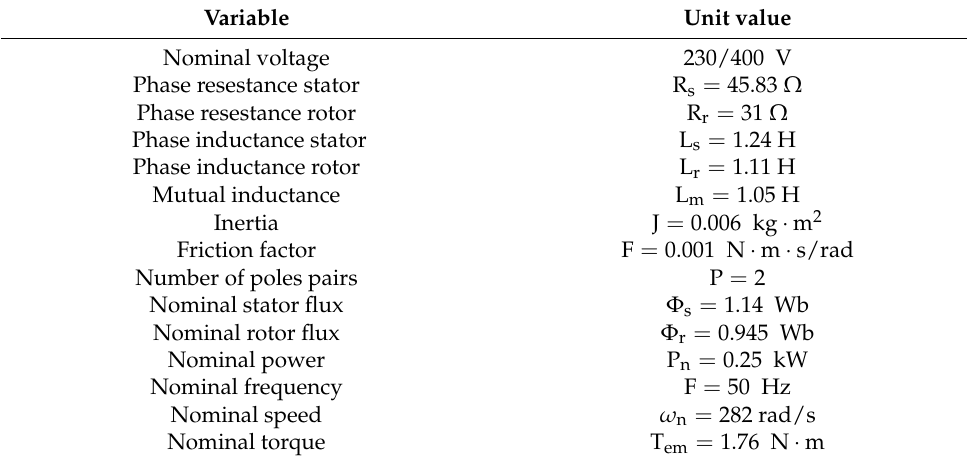
Table A1. The IM nameplate data and